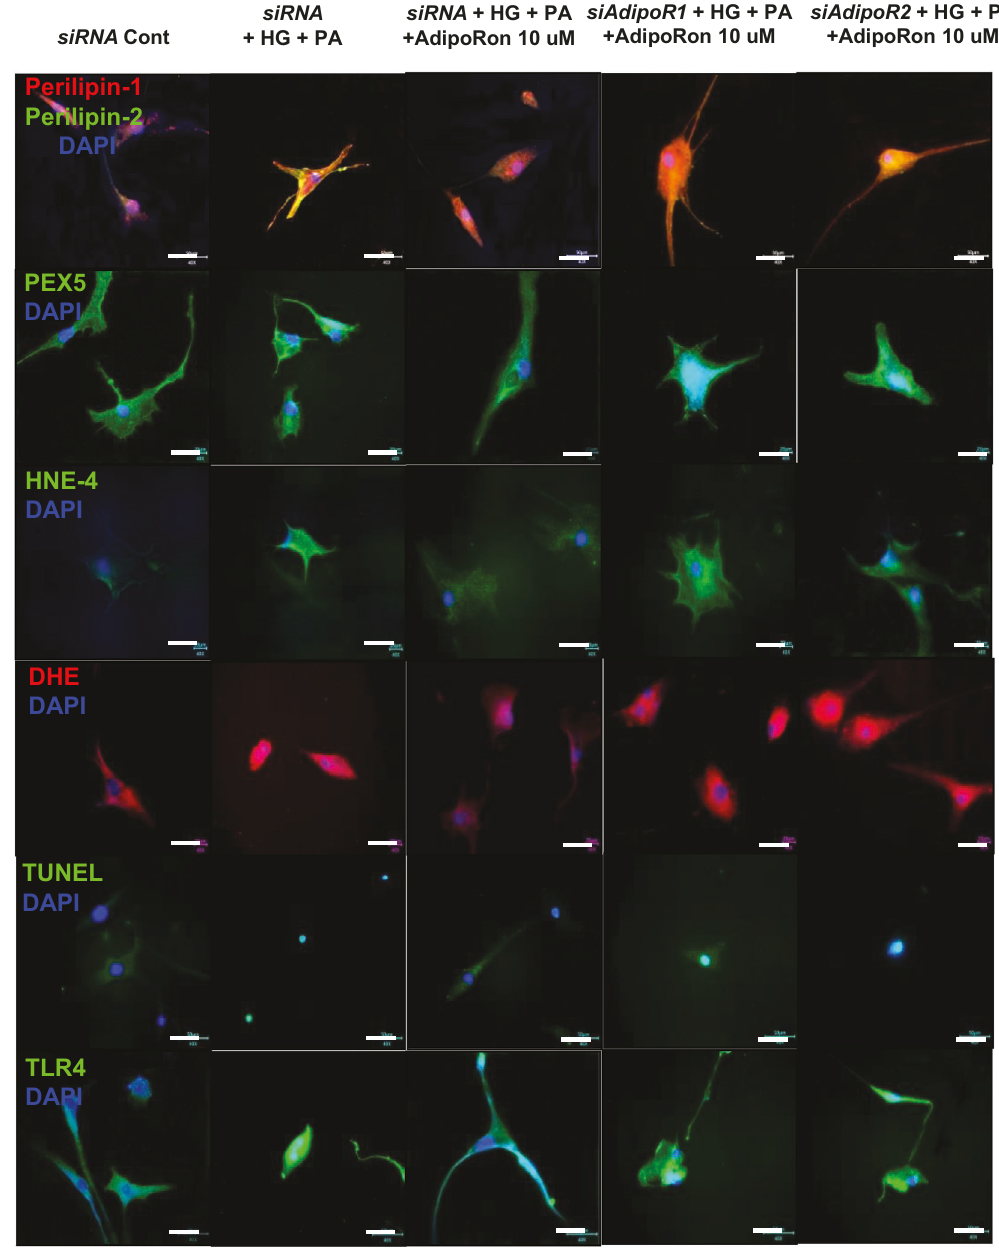
Fig. 6 Effect of AdipoR1 and AdipoR2 siRNAs on oxidative stress and ceramide metabolism in human cardiomyocytes cultured in low- or high-glucose and palmitate media with or without AdipoRon. a Representative images of immuno fl uorescence staining of perilipin-1/-2, PEX5, HNE4, DHE, TUNEL, and TLR4 expressions. b – h Quantitative analyses according to groups. i Representative images of western blotting of perilipin-1/-2, PEX5, HNE4, TLR4, and actin levels. j – n Quantitative analyses according to groups. o – q Quantitative analyses of acid ceramidase, sphingosine 1 phosphate, and PP2A activity according to groups. * P < 0.05, ** P < 0.01, and # P < 0.001 compared with other groups. Scale bars, 50 μ m (in a